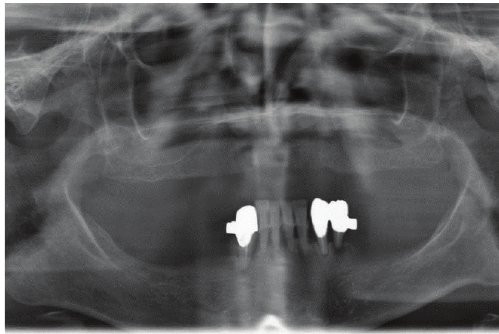
Figure 1: Panoramic X-ray with periodontal teeth. Figure 2: Denture with radiopaque markers used as template.